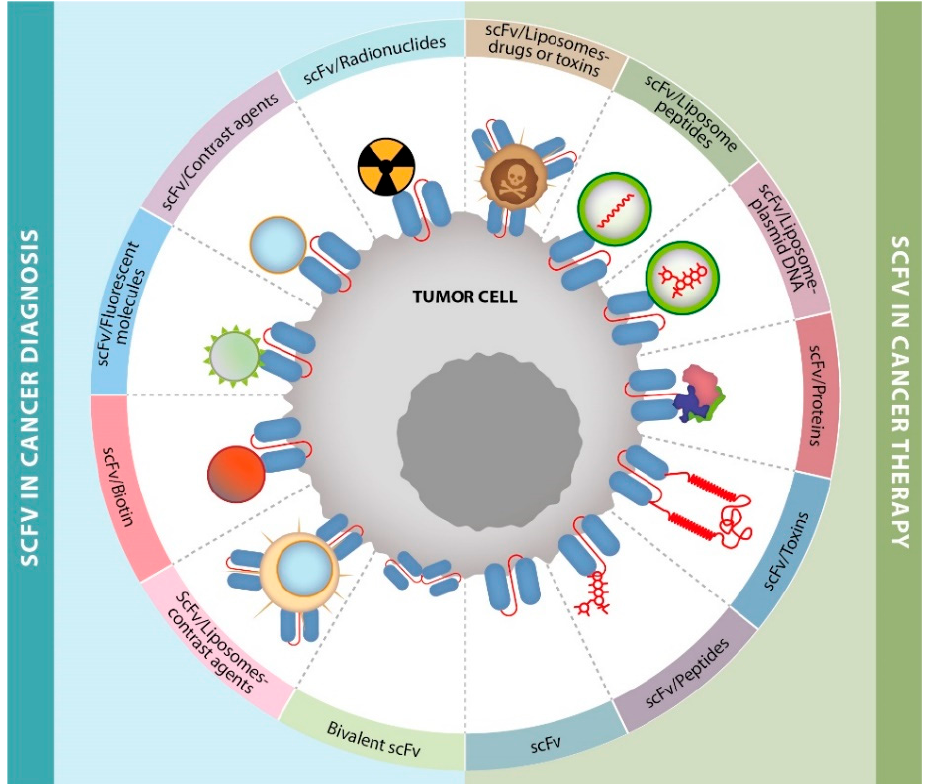
Figure 2. ScFv applications in cancer diagnosis or therapy. Specific scFvs have been used for diag- nosis when coupled with: (A) radioisotopes, (B) contrast agents, (C) fluorescent molecules, (D) biotin, and (E) scFvs conjugated to liposomes loaded with contrast agents. Specific scFvs have also been used with therapeutic purposes for the delivery and/or release of several molecules, such as: (H) peptides, (I) toxins, (J) proteins, (K) plasmid-loaded liposomes, (L) peptide-loaded liposomes, and (M) scFvs conjugated to liposomes loaded with chemotherapy agents.